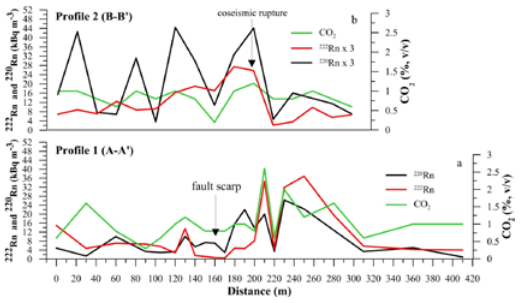
Figure 2. Radon isotopes ( 222 Rn and 220 Rn) and CO 2 soil gas profiles carried out across a fault scarp of the Mt. Vettore fault (profile 1, A-A’) (a), and across a coseismic rupture (profile 2, B-B’). The radon isotope activity along the profile 2 is multiplied by 3 in order to better highlight peaks and for an easy comparison with the higher activi- ties measured along the profile 1.